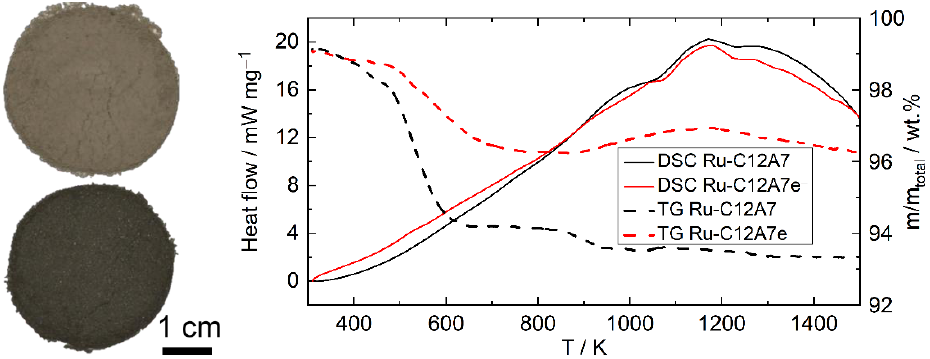
Figure 1. Left top to bottom: photographs of (f) 1.2 wt.%-Ru/C12A7 and (i) Ru/C12A7e − (3C) pow- ders after Ru deposition. Right: DSC (heat flow, exothermic up, solid) and TG (m/m total , dashed) curves under synthetic air for (f) shown in black and (i) shown in red. 10 mg of sample each was heated with a ramp of 10 K · min −1 from RT to 1573 K.